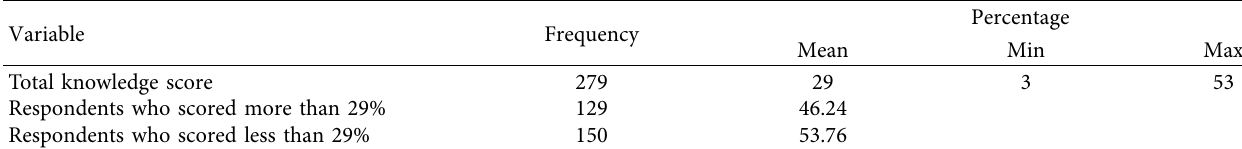
Table 11: General knowledge of nurses on blood transfusion administration at